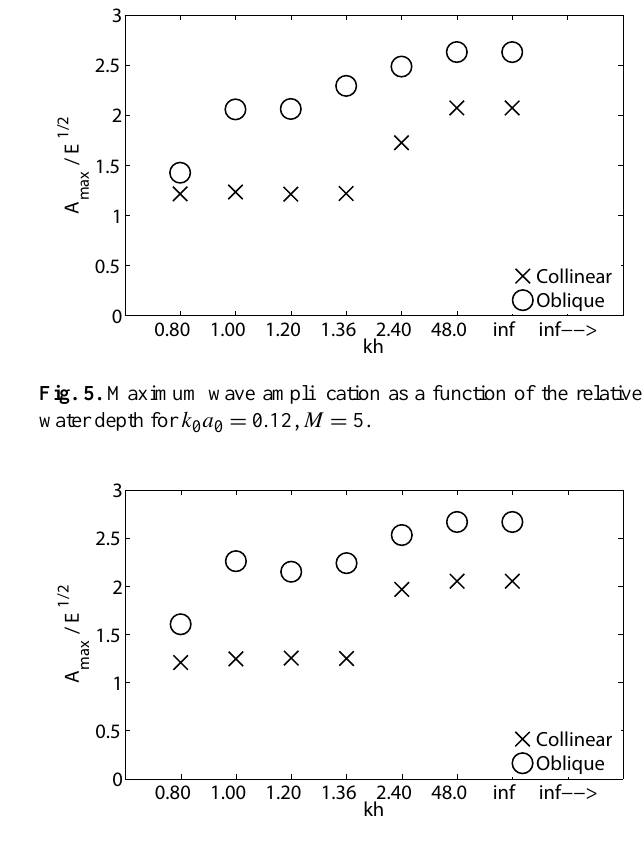
Fig. 6. Maximum wave amplification as a function of the relative water depth for k 0 a 0 = 0 . 14, M =